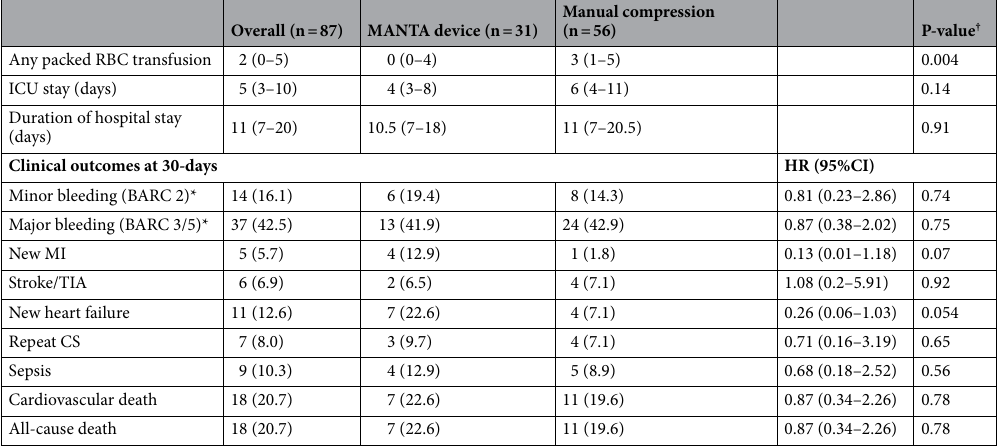
Table 4. Clinical outcomes at 30-day. Data are median (interquartile range) or number (percentage), as appropriate. BARC, Bleeding Academic Research Consortium; CS, cardiogenic shock; HR, hazard ratio; ICU, intensive care unit; MI, myocardial infarction; RBC, red blood cells; TIA, transient ischemic attack. *Any additional bleeding occurring within 30 days of follow-up. † P values were based on Man-Whitney-U test or cox regression as